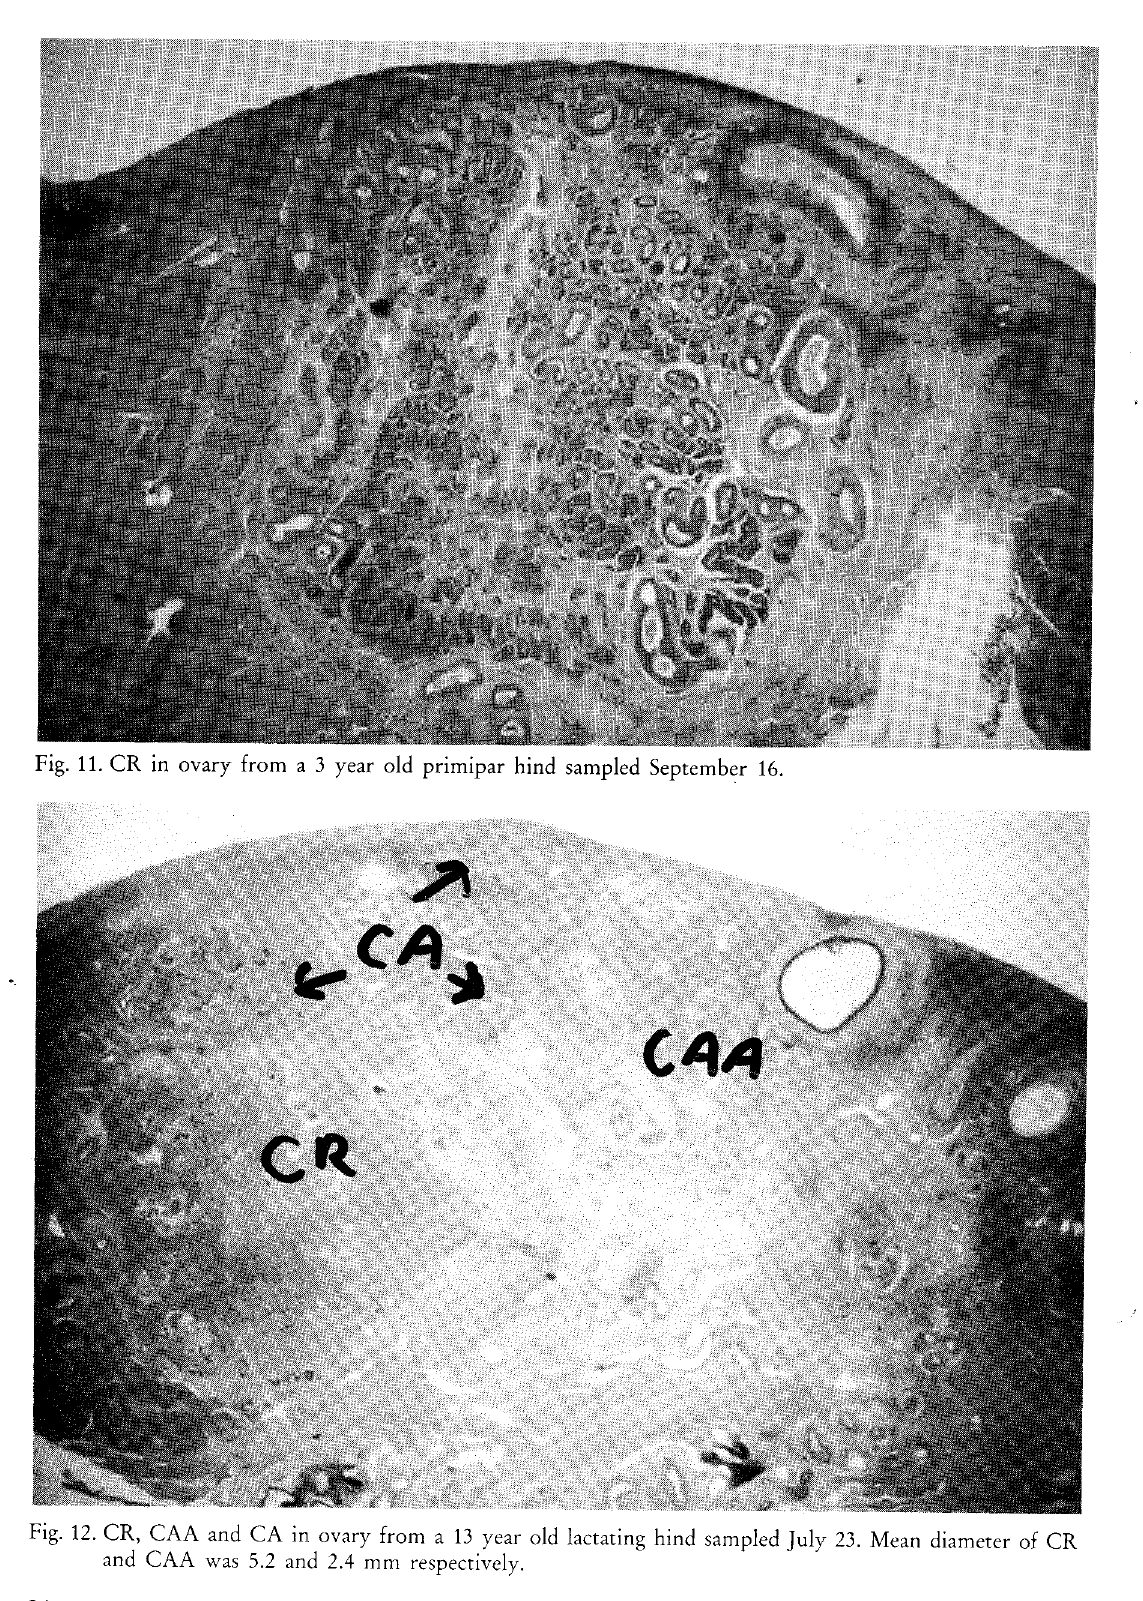
Fig. 11. CR in ovary from a 3 year old primipar hind sampled September